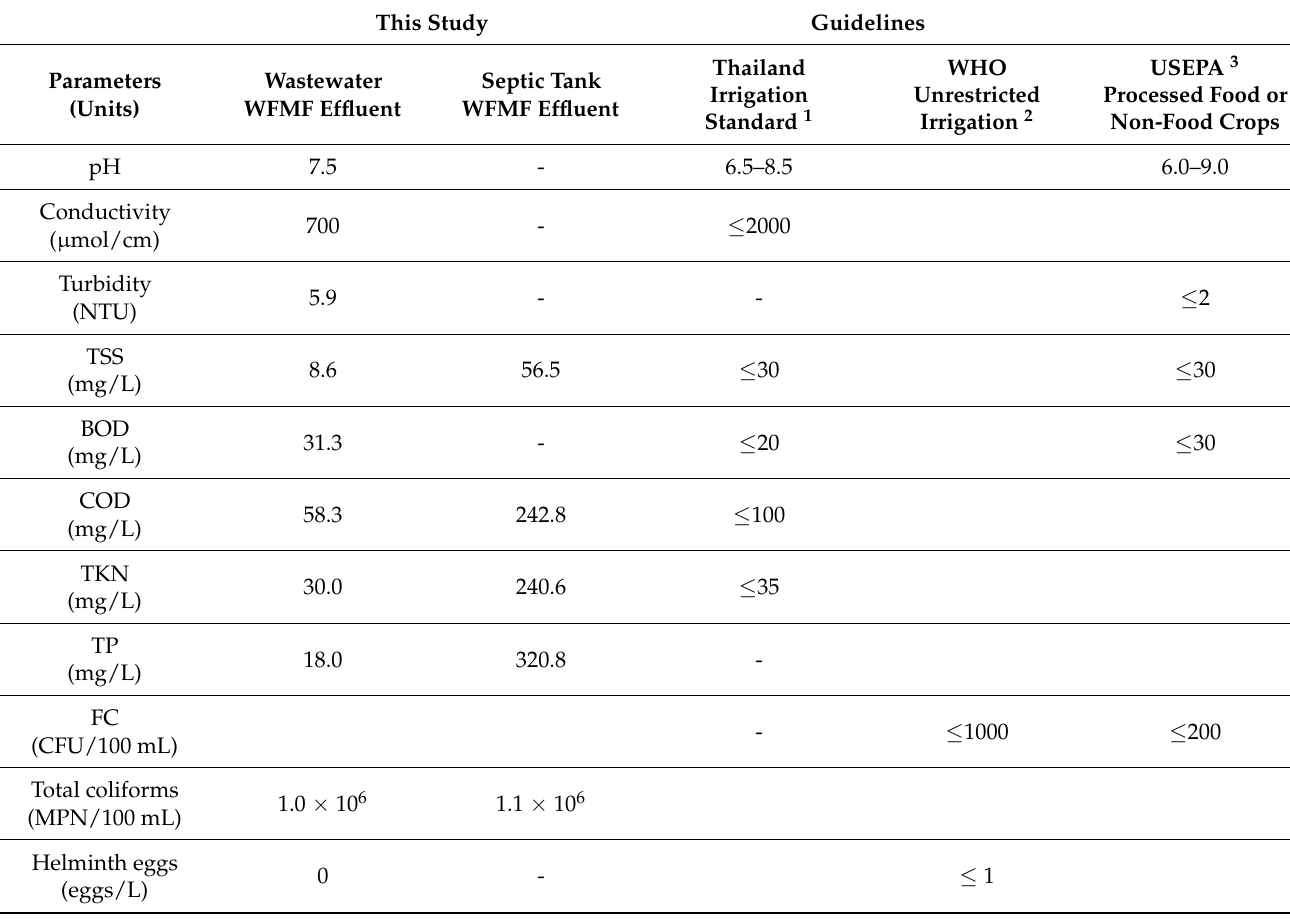
Table 2. Characteristics of WFMF permeate compared to existing guidelines for water